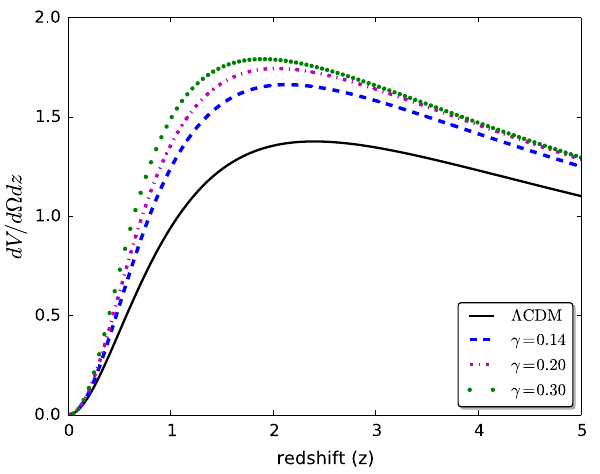
Fig. 7 The comoving volume element versus redshift for various val- ues of the γ exponent. Increasing γ shifts the position of the maximum value of the volume element to lower redshifts. The other free parame- ters have been fixed by an SNIa observational constraint. The Λ CDM best fit is given by Planck observation